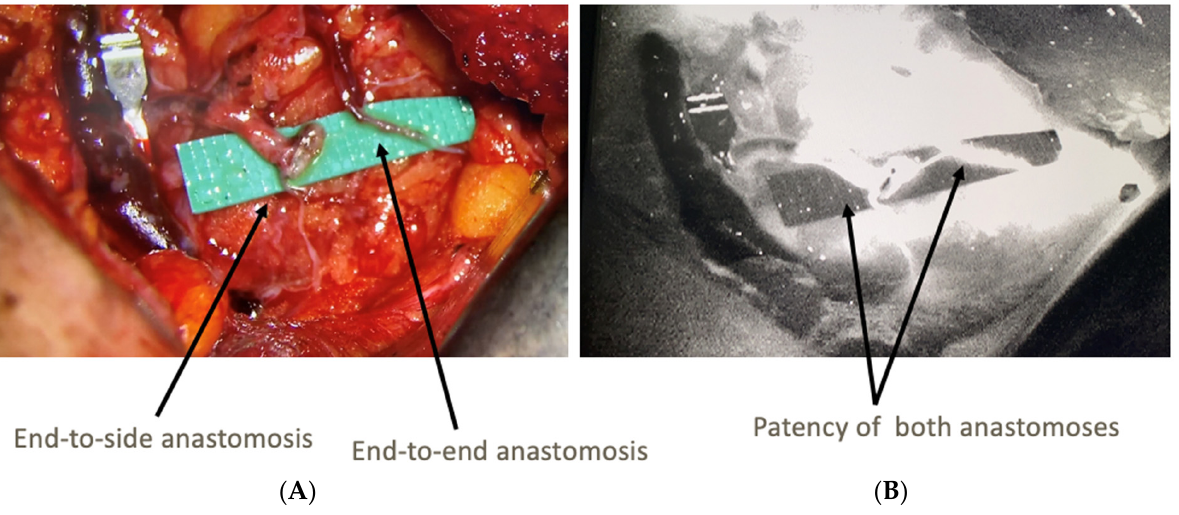
Figure 4. Evaluation of Anastomosis: ( A ) demonstrates two types of anastomoses, end-to-side and end-to-end, that can be performed depending on the size match between the lymphatic and recipient vein. After completion of the anastomoses, ( B ) shows patency of the LVAs using ICG and SPY.